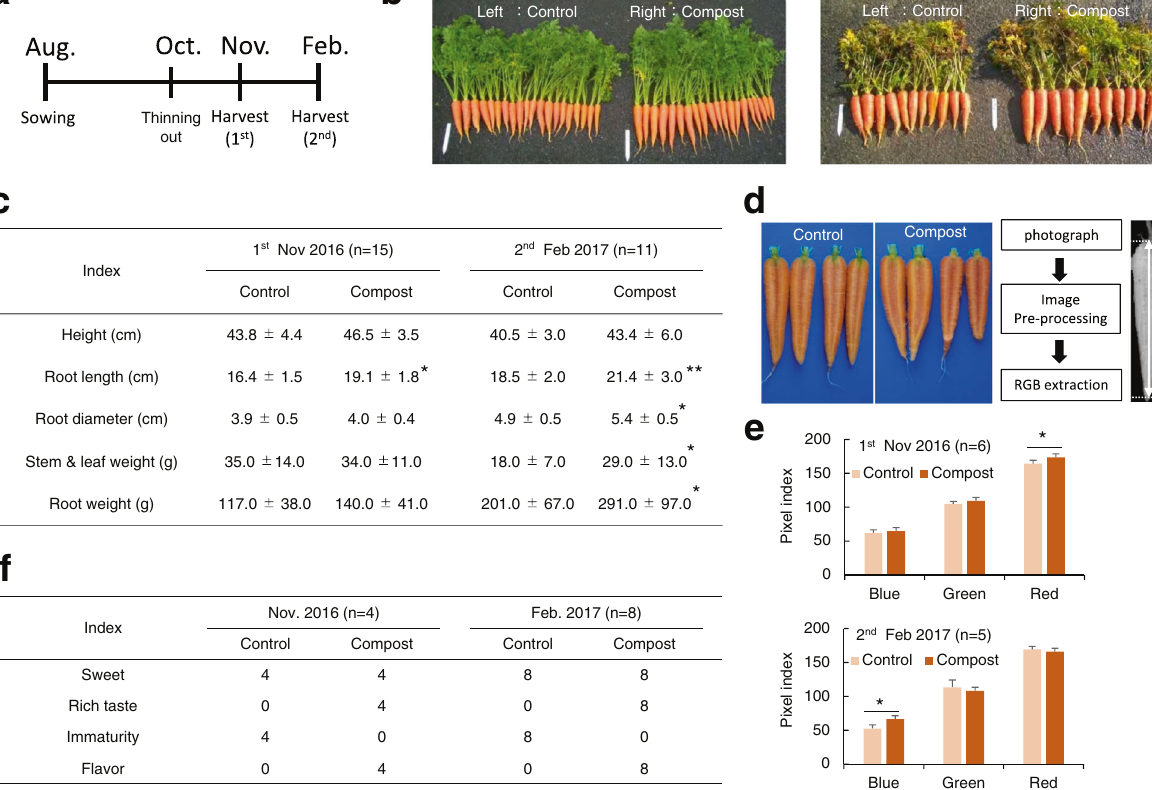
(Fig. 2f). Regardless of the difference in RGB color, little difference in taste evaluation was observed.. These observations con fi rmed that the compost amendment improved the indices of carrot production and quality in this study.